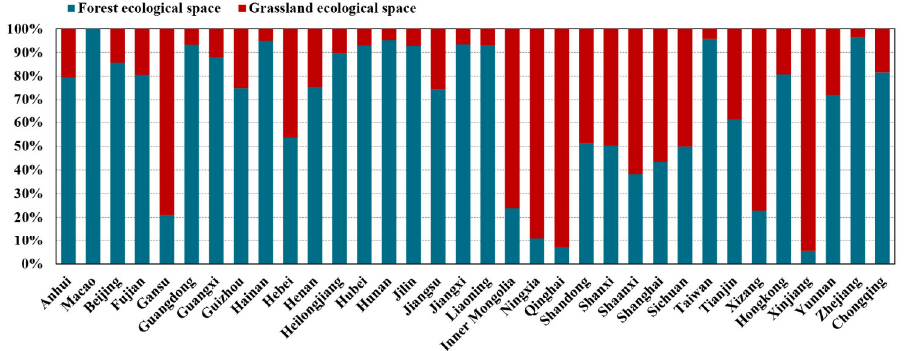
Figure 1. The area proportion of forest ecological space and grassland ecological space in different provinces of China.